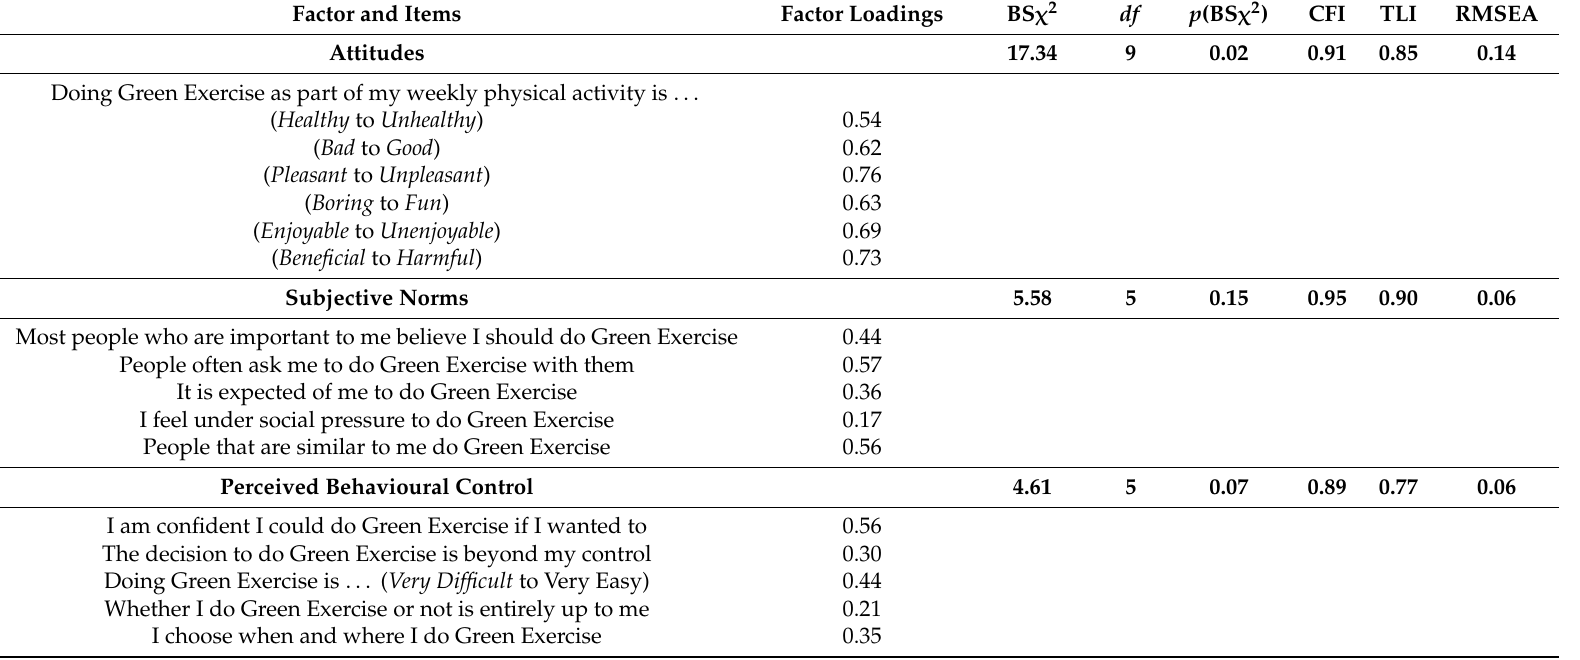
Table 5. Fit statistics and factor loadings of single-factor models of the beliefs about green exercise (BAGE). Factor and Items Factor Loadings BS χ 2 df p (BS χ 2 ) CFI TLI RMSEA Attitudes 17.34 9 0.02 0.91 0.85 0.14 Doing Green Exercise as part of my weekly physical activity is . .